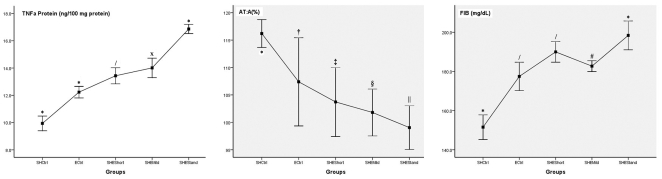
TNFα protein and FIB increase from SHCtrl to SHEStand while AT shows the obverse tendency.Error bars: +/− 1 SD. P<0.05 is considered statistically significant in Bonferroni post hoc multiple comparisons between internal groups. Unless otherwise stated, there is significant difference compared with other groups. * different with others; /not different with SHEMild; x not different with SHEShort; † not different with SHEShort and SHEMild; ‡ not different with ECtrl, SHEMild and SHEStand; § not different with ECtrl, SHEShort and SHEStand; || not different with SHEShort and SHEMild; # not different with ECtrl and SHEShort.